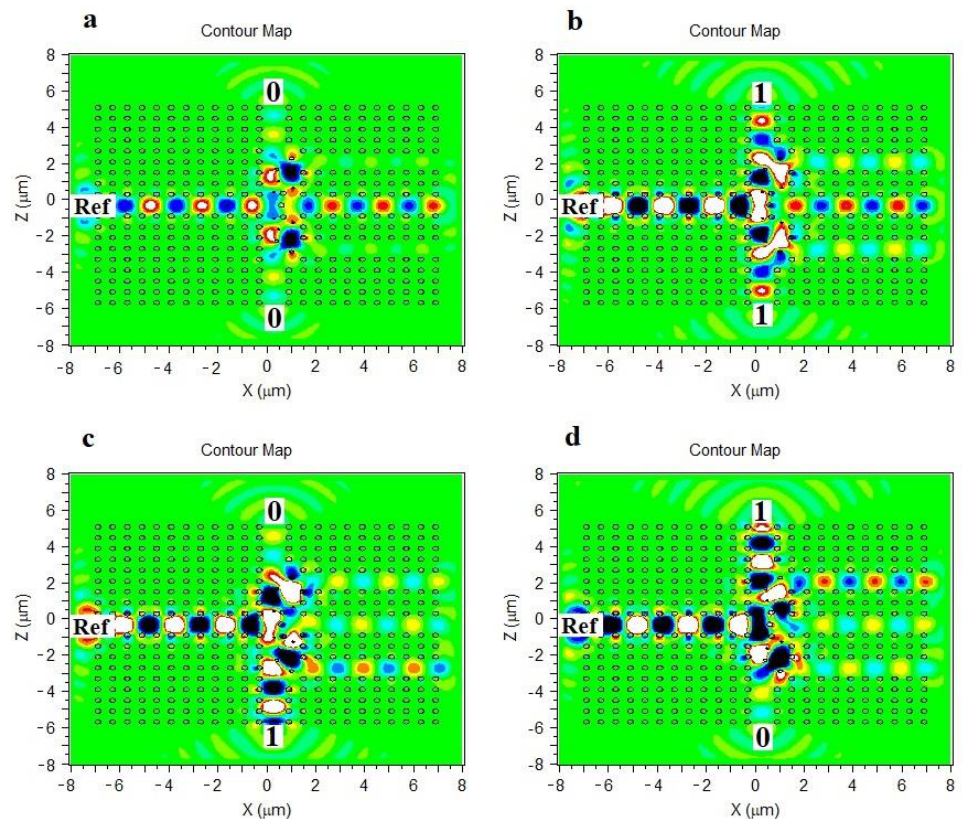
Figure 4. The optical power distribution of the comparator in different input states. ( a ) A = B = 0, ( b ) A = B = 1, ( c ) A = 0 and B = 1, ( d ) A = 1 and B = ( b ) A = B = 1, ( c ) A = 0 and B = 1, ( d ) A = 1 and B = 0.